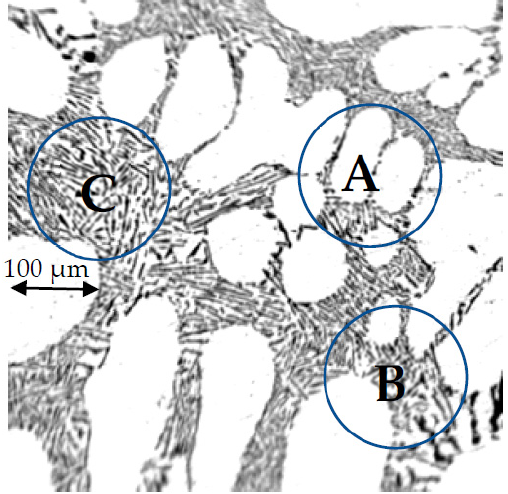
Figure 1. The typical solidified microstructure of nonmodified Al–7wt% Si alloy at a cooling rate of 0.5 K/s.